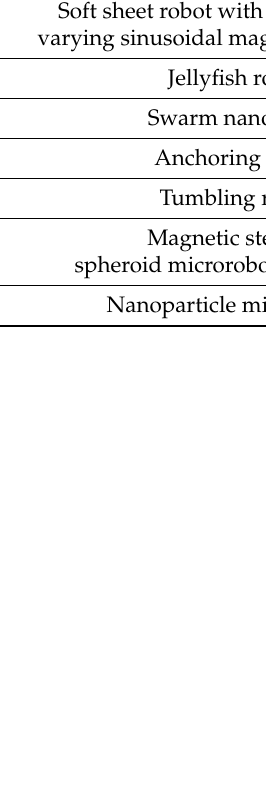
Table 2. Exemplar studies of small-scale magnetic robots with US imaging modality. Small-Scale Magnetic